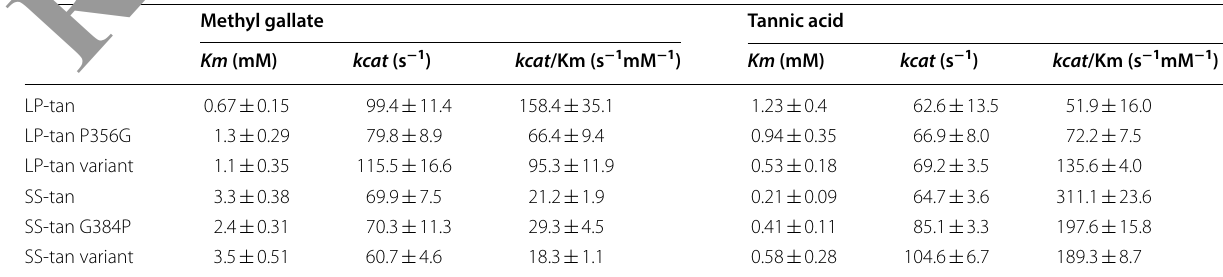
Table 3 Kinetic parameters of LP-tan, SS-tan, LP-tan P356G, SS-tan G384P and the